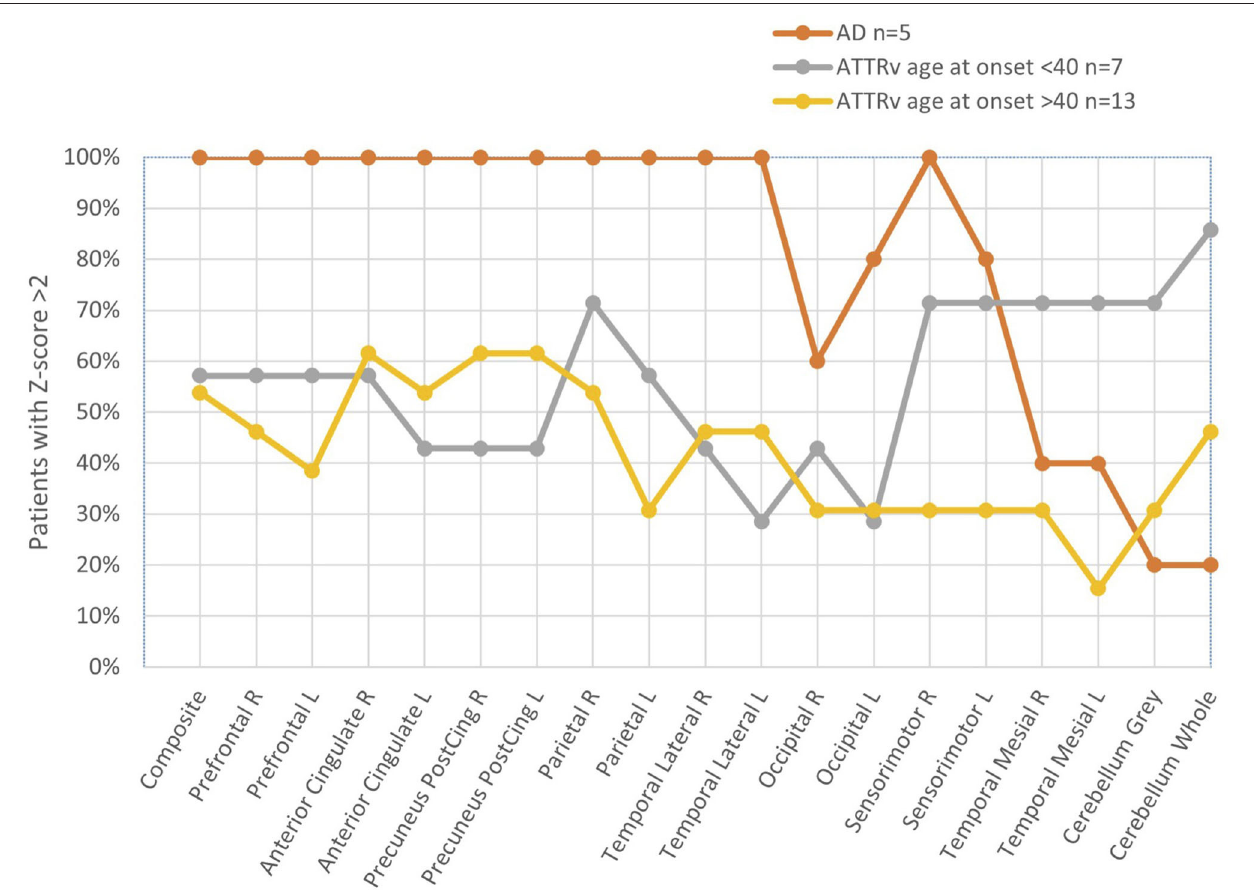
FIGURE 3 | Fraction of patients with pathological Z-score ( > 2) in different brain regions. Curves represent patient groups: AD (orange), ATTR V 30M age < 40 (gray), and ATTR V30M age > 40 years